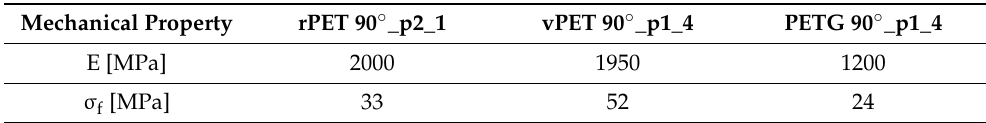
Table 8. E-modulus, presented on the first row, and tensile stress, presented on the second row, of the samples in Figure 15.